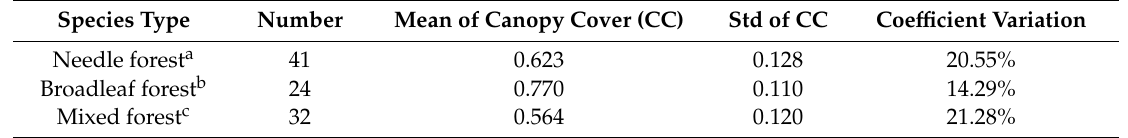
Table 4. Canopy cover characteristics of each forest type.